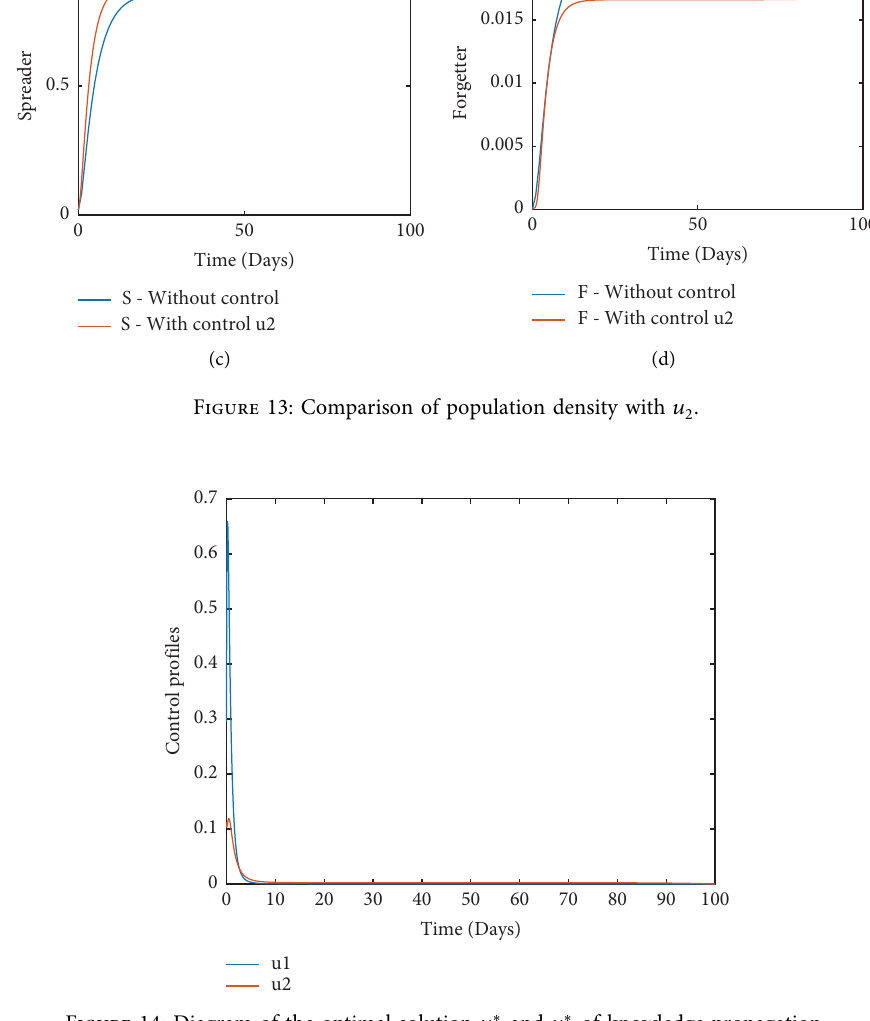
and u ∗ of knowledge propagation. 1 2